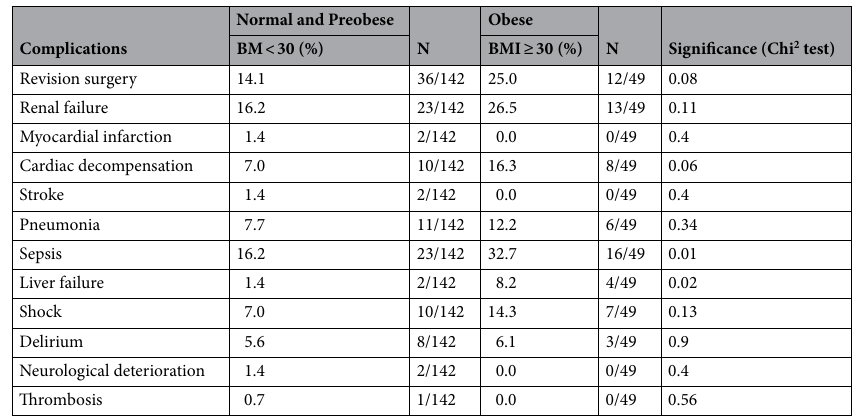
Table 4. Complications according to body-weight. There are significantly higher rates of sepsis and liver failure in obese patients. Revision surgery and cardiac decompensation rates are almost significant for obese